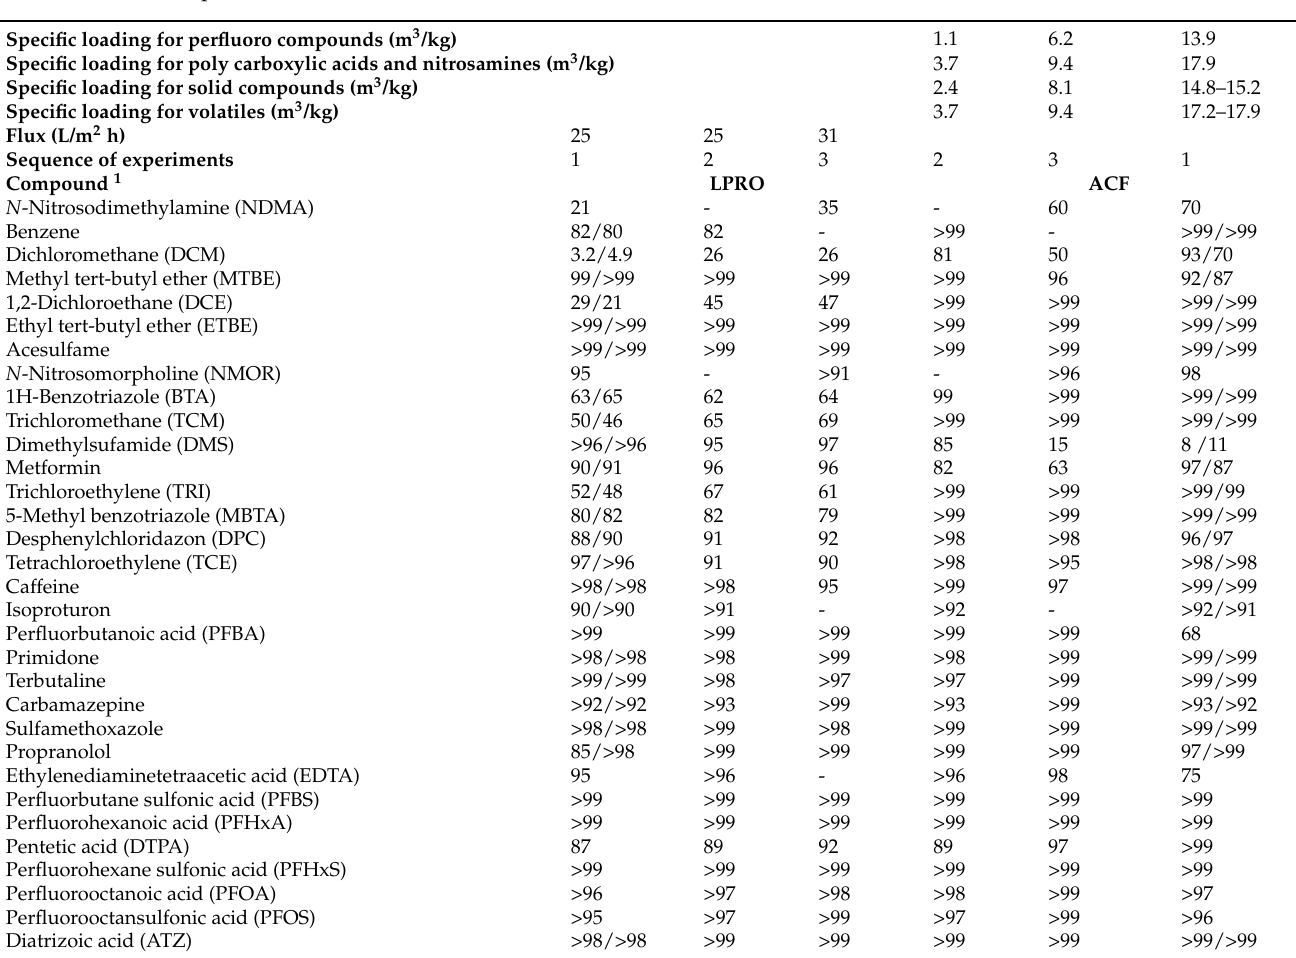
Table 7. Removal values (%) of TrOCs by LPRO (for different fluxes) and ACF processes (ACF data sorted according to the increase in the specific load of